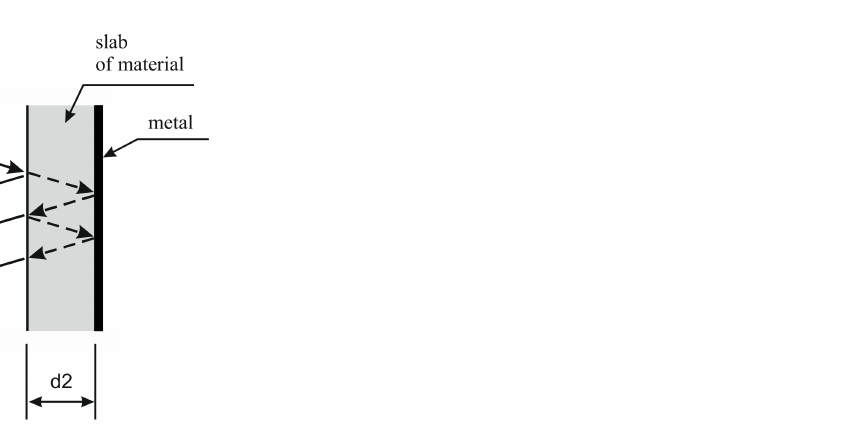
Figure 4. Schematic presentation of reflected rays from material backed with metal.